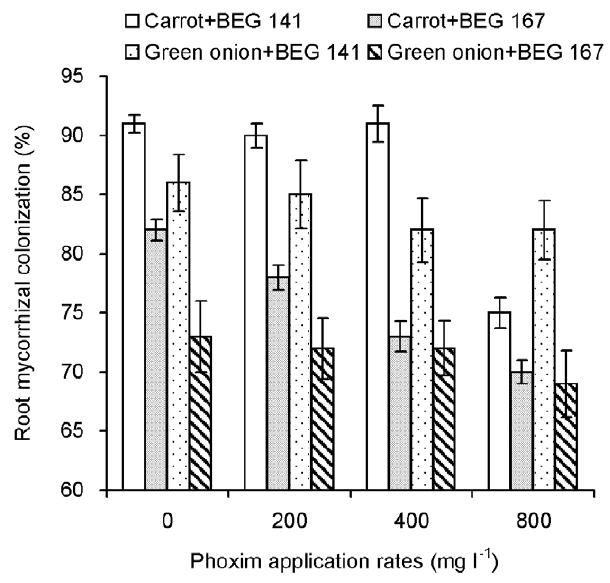
Figure 1. Root mycorrhizal colonization (%) (means ± SE, n =3) of carrot and green onion. BEG 141 and BEG 167: G. intraradices BEG 141 and G. mosseae BEG 167, respectively.